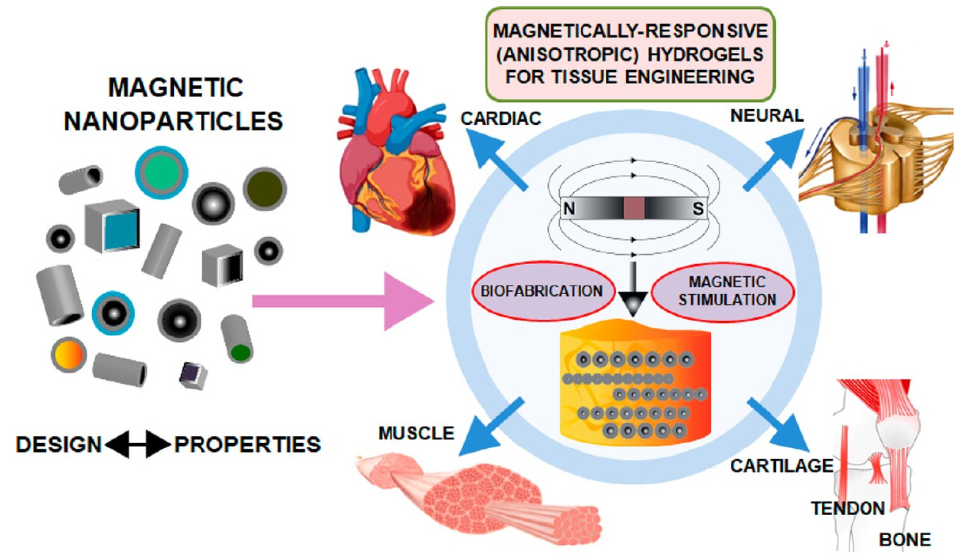
Figure 3. Schematic illustration: use of magnetic hydrogels to engineer different tissues of the hu- man body. Reproduced from [84] with permission. Copyright 2021 American Chemical